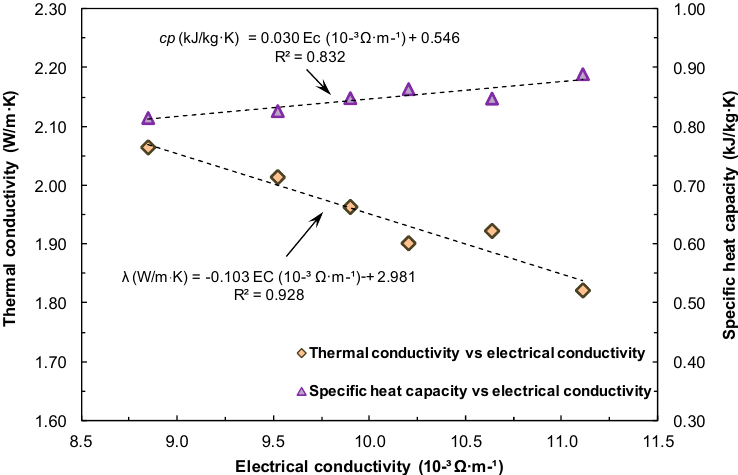
Figure 10. Variation in electrical conductivity / thermal conductivity and electrical conductivity / specific heat capacity relationships for all concrete mixes.